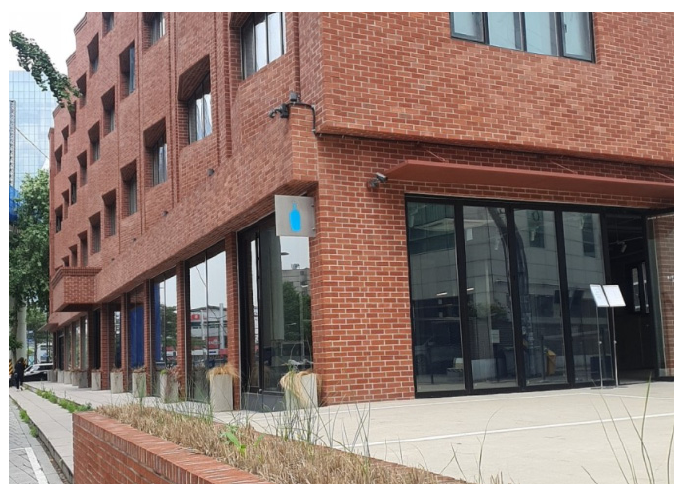
Figure 22. Blue Bottle, The Exchange, Boston [73].